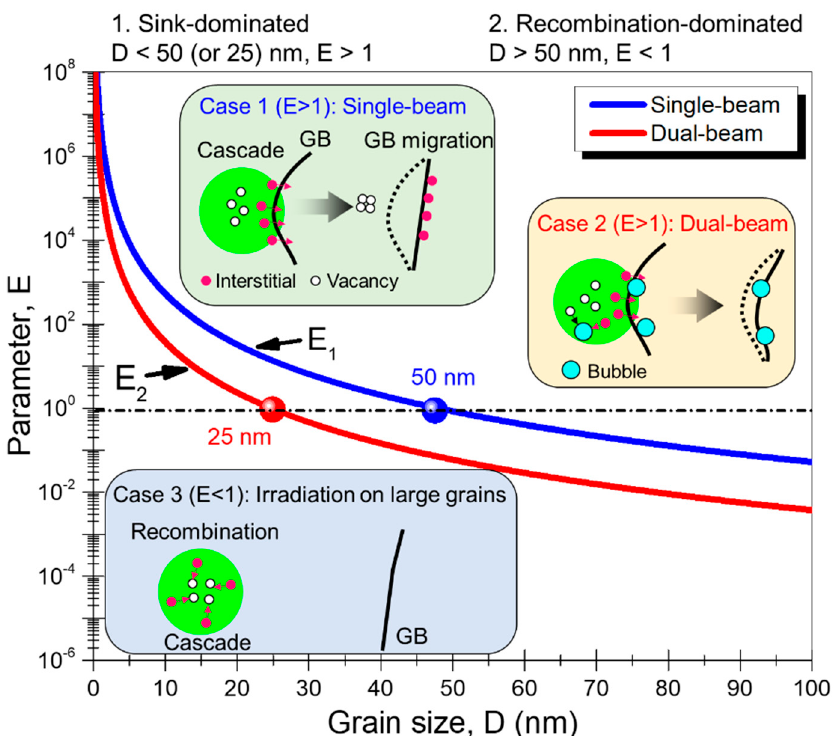
Figure 6. E parameter (logarithmic scale) versus grain size for single-beam (blue curve) and dual-beam (red curve) irradiated Cu at 300 ◦ C. Case 1: Single-beam irradiation on small grains. Case 2: Dual-beam irradiation on small grains. Case 3: Irradiation of large grains. See the text for more